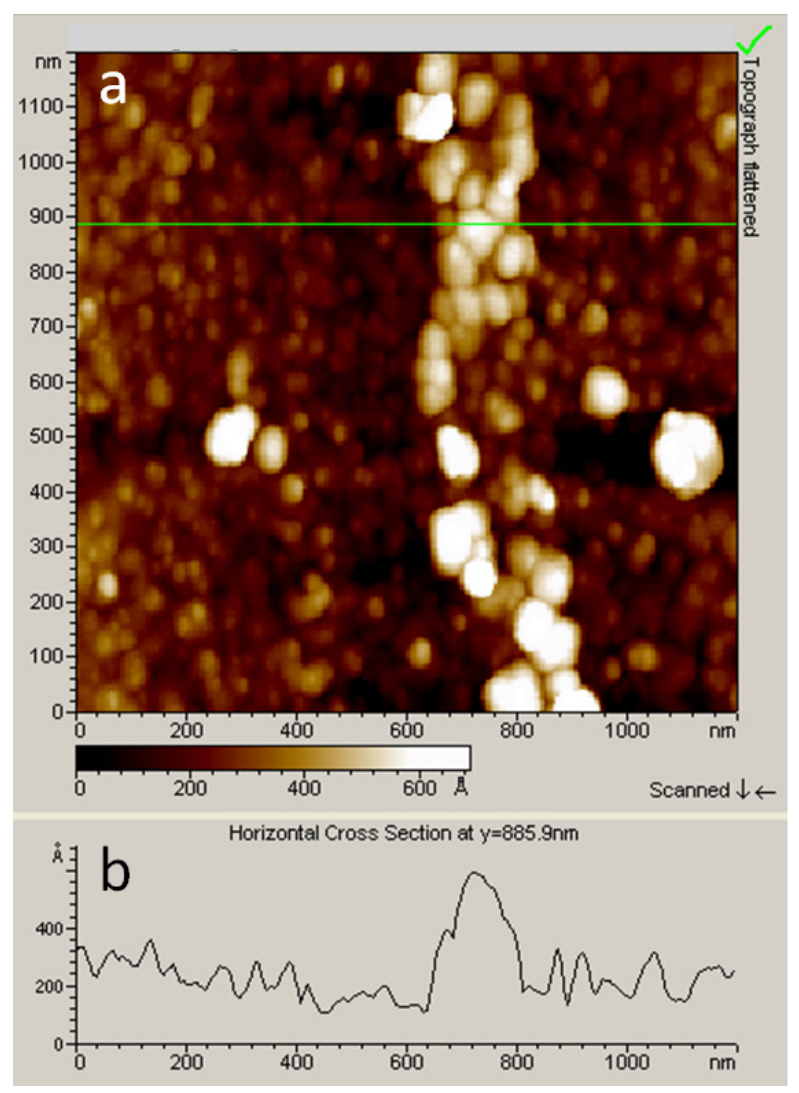
Figure 6. ( a ) Topographic AFM image in tapping mode of the line pattern drawn with the AFM-SECM-electrode on the gold surface with direct aryl diazonium salt/acrylic acid reduction (chronoamperometry: − 0.8 V); ( b ) Horizontal cross section of the electrografted line. Line width and height are about 180 nm and 40 nm,